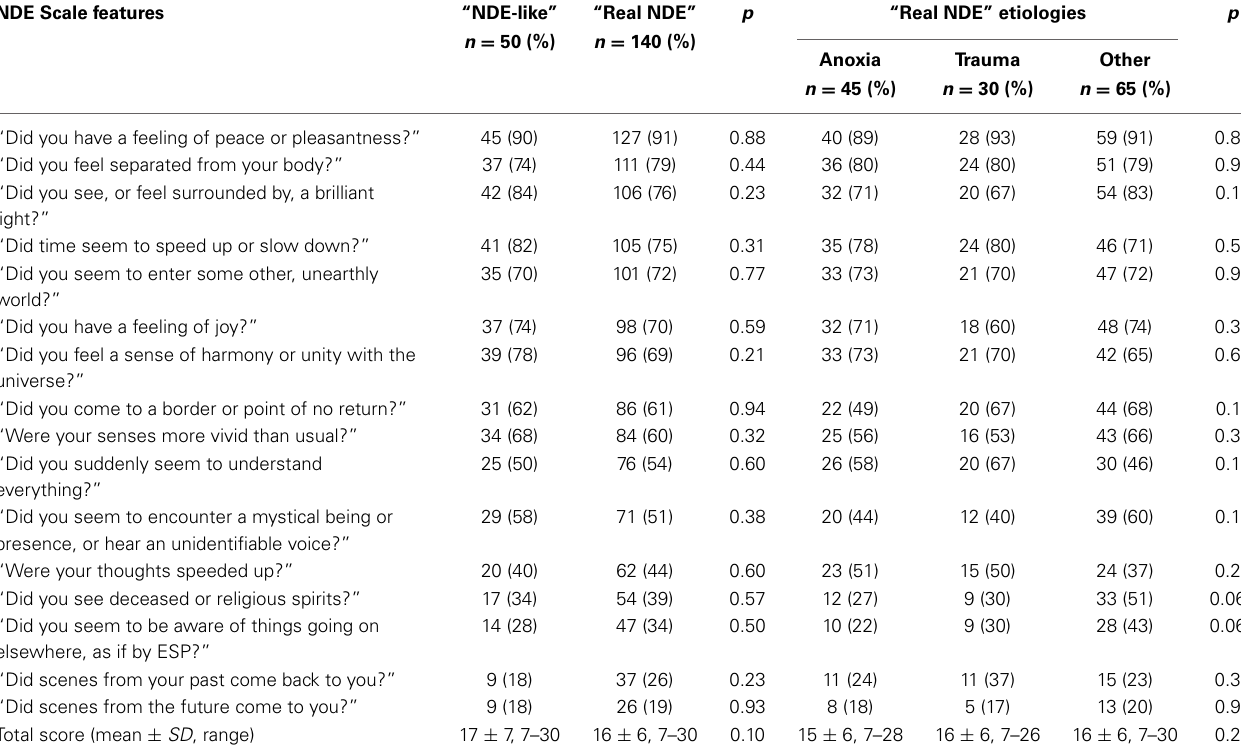
Table 2 | NDE intensity (Greyson Scale total score) and content (core features) reported in “NDE-like” and “real NDE” groups–by decreasing order of frequency according to the “real NDE” group (significance level p < 0 .